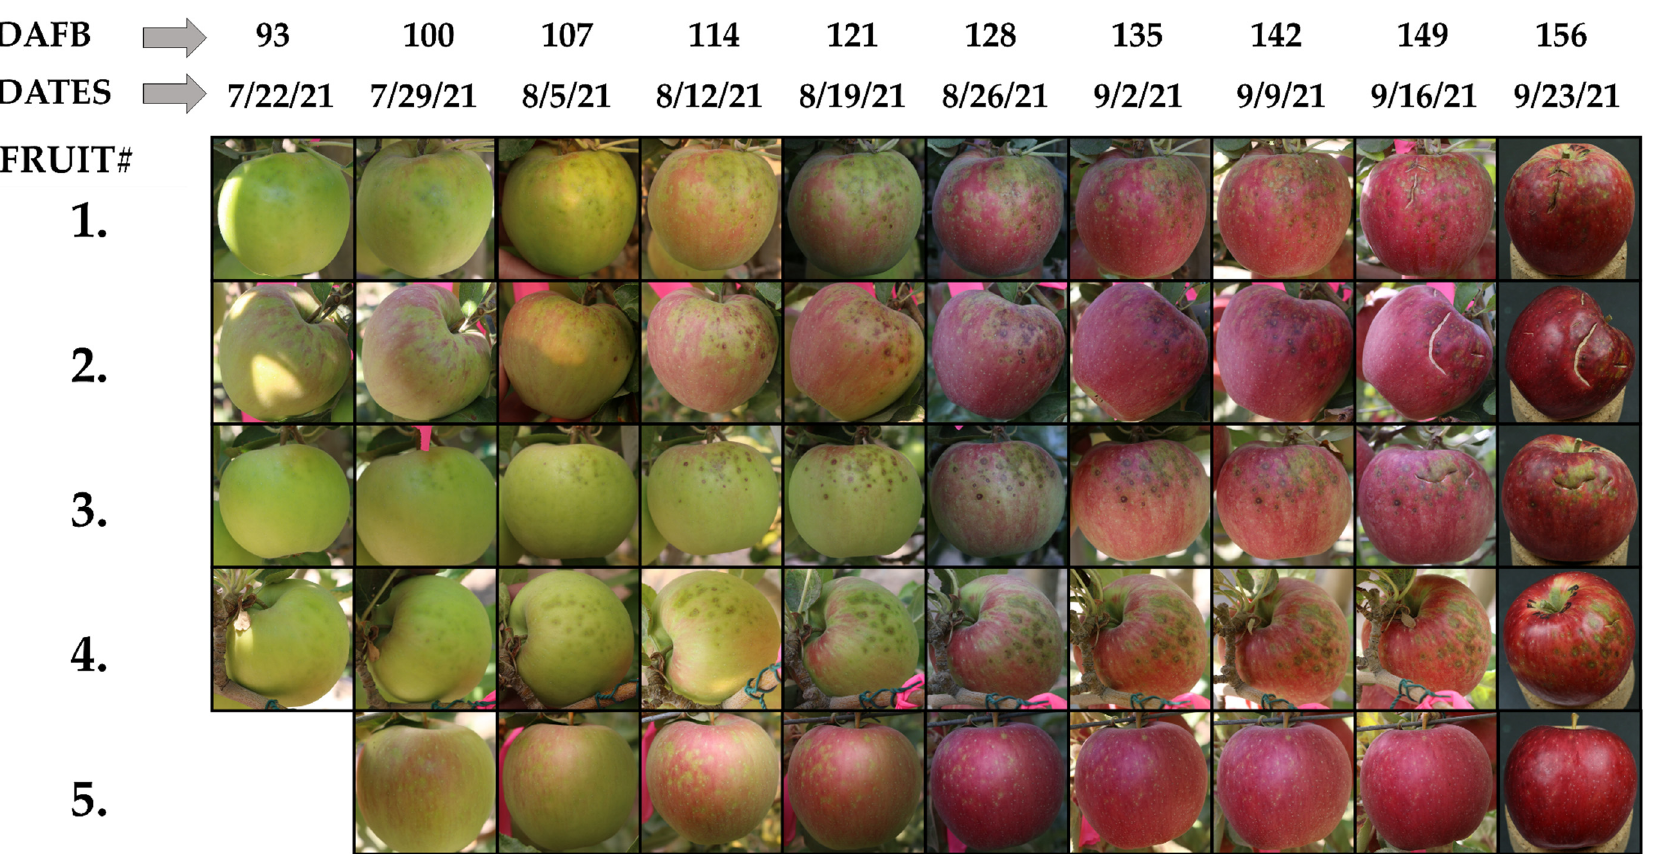
Figure 1. The progression of GS symptoms over time in ‘WA 38’ apples in 2021. On top of the fruit progression picture the dates of the photo are reported in days after full bloom (DAFB) and in calendar dates. The first GS symptoms were observed and photographed on 22 July 2021 (Fruit # 1–4) and were photographed weekly until they were harvested and photographed on 23 September 2021. Fruits # 1–4 developed severe green spot symptoms by harvest, while Fruit # 5. developed only mild symptoms that became less conspicuous in the weeks leading up to harvest. Early symptoms on Fruit # 5 were first observed on 29 July 2021.